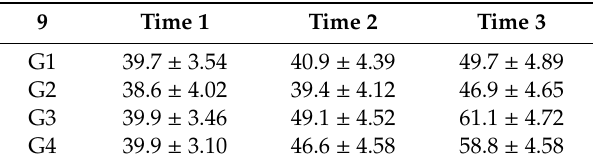
Table 1. Table data (mean and standard deviation) of implant stability quotient (ISQ) values measured of each group for each time. 9